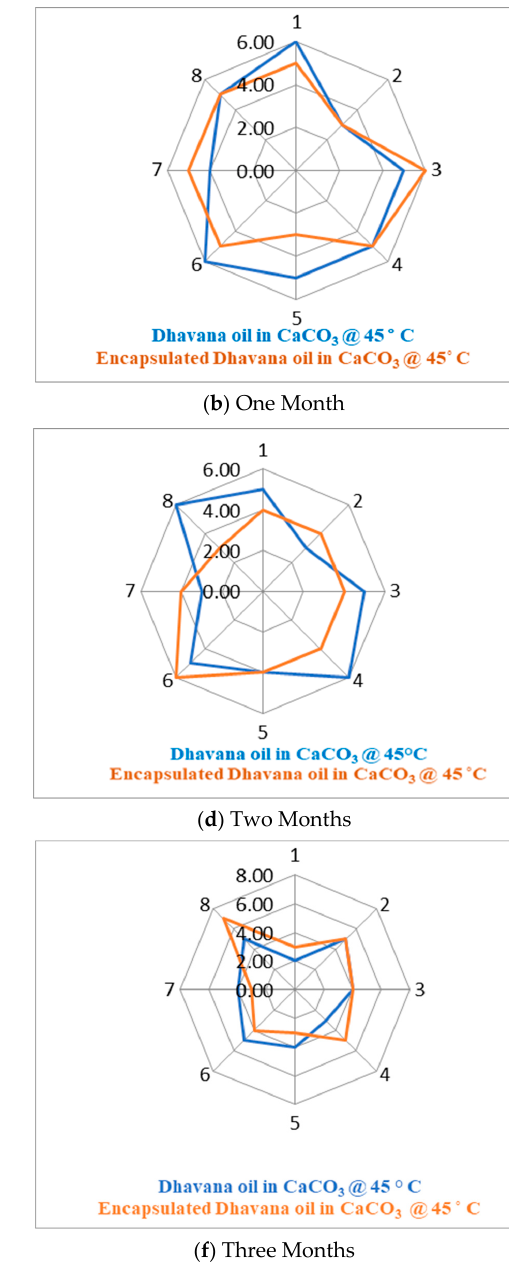
Figure 4. ( a – f ) Olfactory analysis of neat and encapsulated Dhavana oil in TALC and CaCO 3 up to 3 months at 45 °C . Olfactive analysis shows that at 45 °C , intensity score for encapsulated Dhavana oil in TALC and CaCO 3 was less than the neat oil in both the base matrix. Thus, it supports that the encapsulated Dhavana oil is more stable than neat oil after one-, two-, and three months. Olfactive analysis and radar plot show that at 45 °C , intensity score of encapsu- lated Dhavana oil in TALC was less than the neat oil in the first, second, and third months. Intensity score of encapsulated Dhavana oil in CaCO 3 was less than the neat oil for the first month, but the same was not similar but higher in the second and third months. Com- parison of intensity scores of neat Dhavana oil in TALC and CaCO 3 showed in Table 9 below. A higher intensity score of encapsulated Dhavana oil in CaCO 3 showed leakage of capsules. It supports that encapsulated Dhavana oil is more stable than neat oil in TALC compared to CaCO 3 after three months.